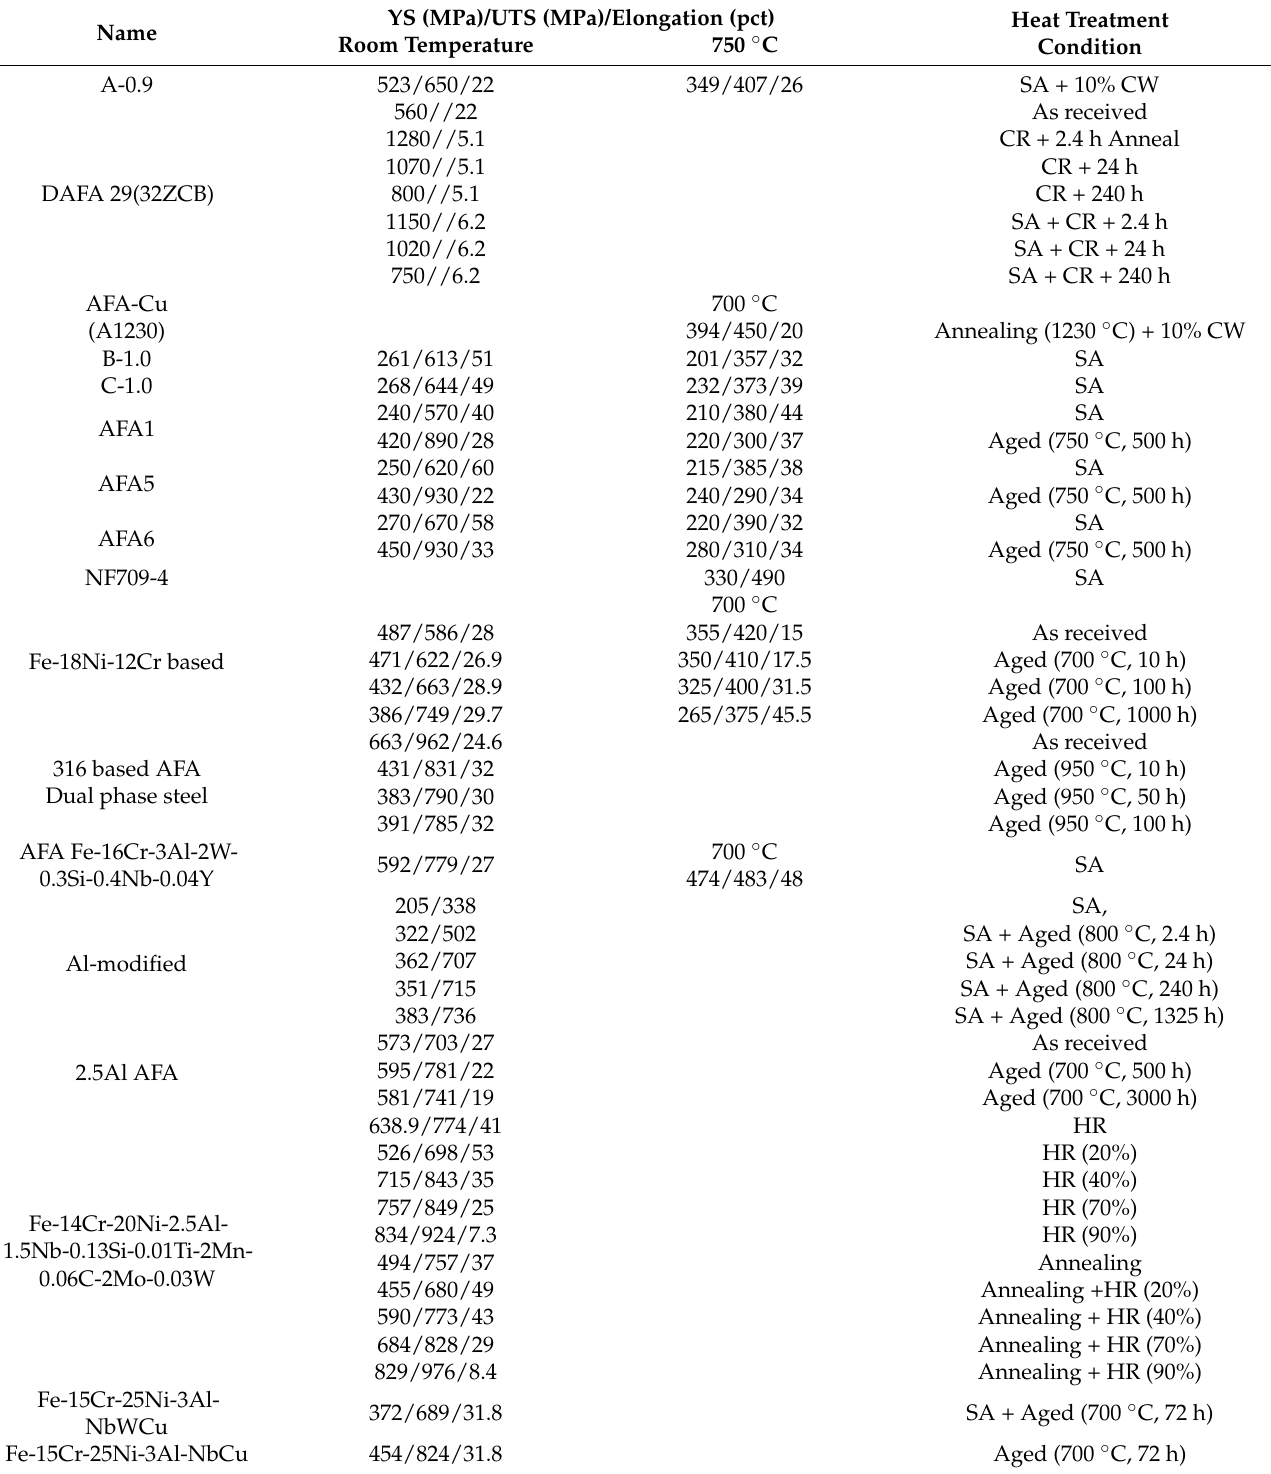
Table 4. The short-term mechanical properties of AFA